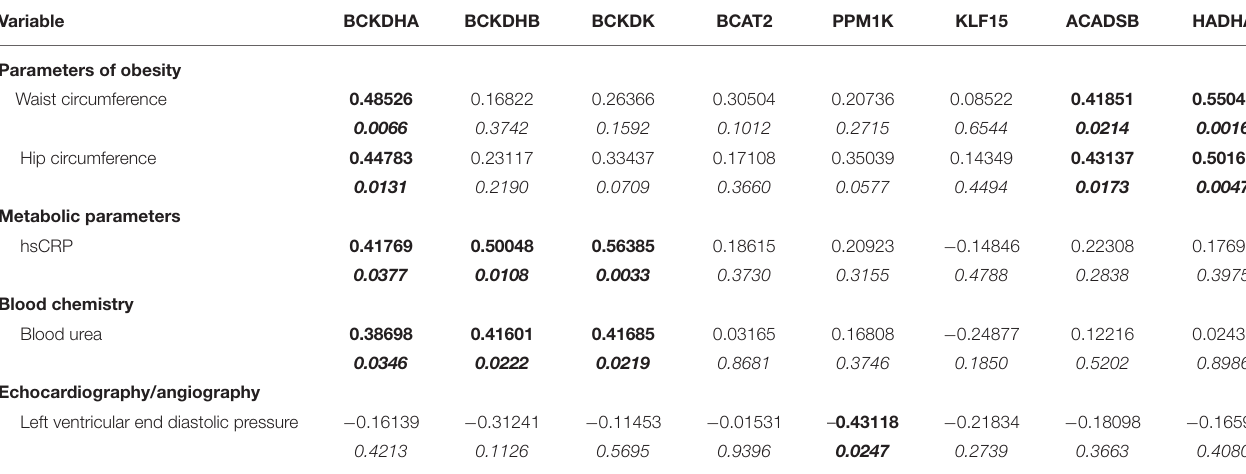
TABLE 5 | Unadjusted Spearman’s correlations for mRNA expression data of BCAA pathway enzyme in AA from cardiac surgery patients. Variable